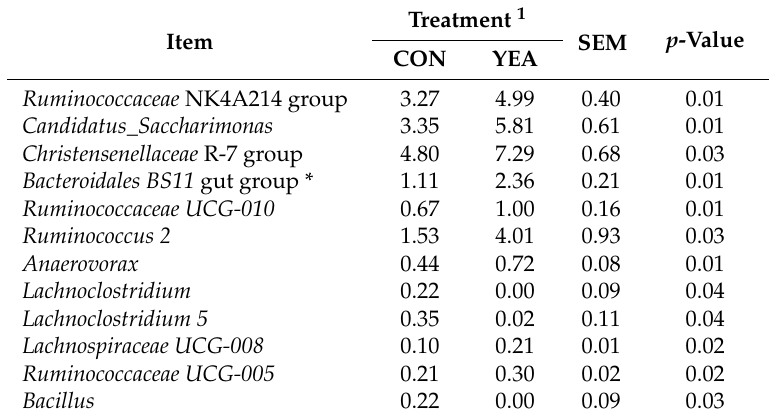
Table 2. Relative abundance of the dominant ruminal bacterial genera (>0.1% of total sequences) of beef steers fed no or 15 g/d of live yeast product.